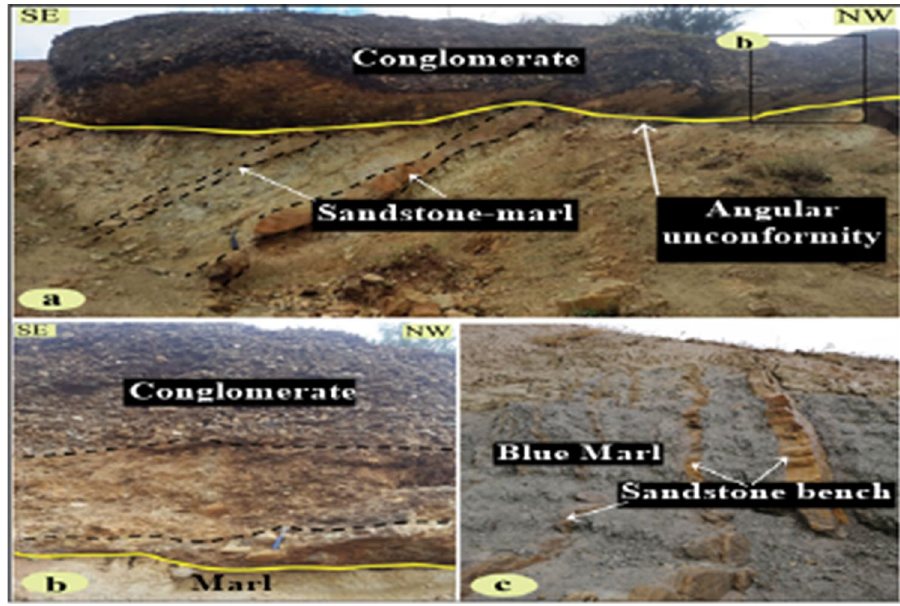
Fig. 5 a Angular discordance between blue marls with lime- stone and sandstone intercala- tions and a level of alluvium; b level of alluvium with a granulation toward the summit; c Blue marl with limestone and sandstone intersections (Torto- nian) affected by normal